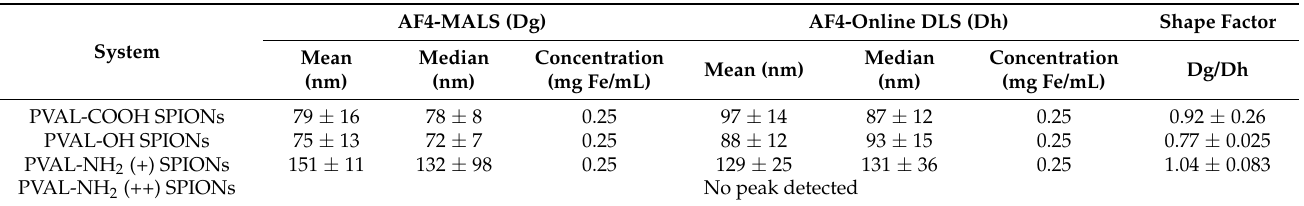
Table 3. Particle sizes obtained by MALS (Dg by random coil model) and online DLS (Dh by cumulant analysis). All values are averaged from 3 different